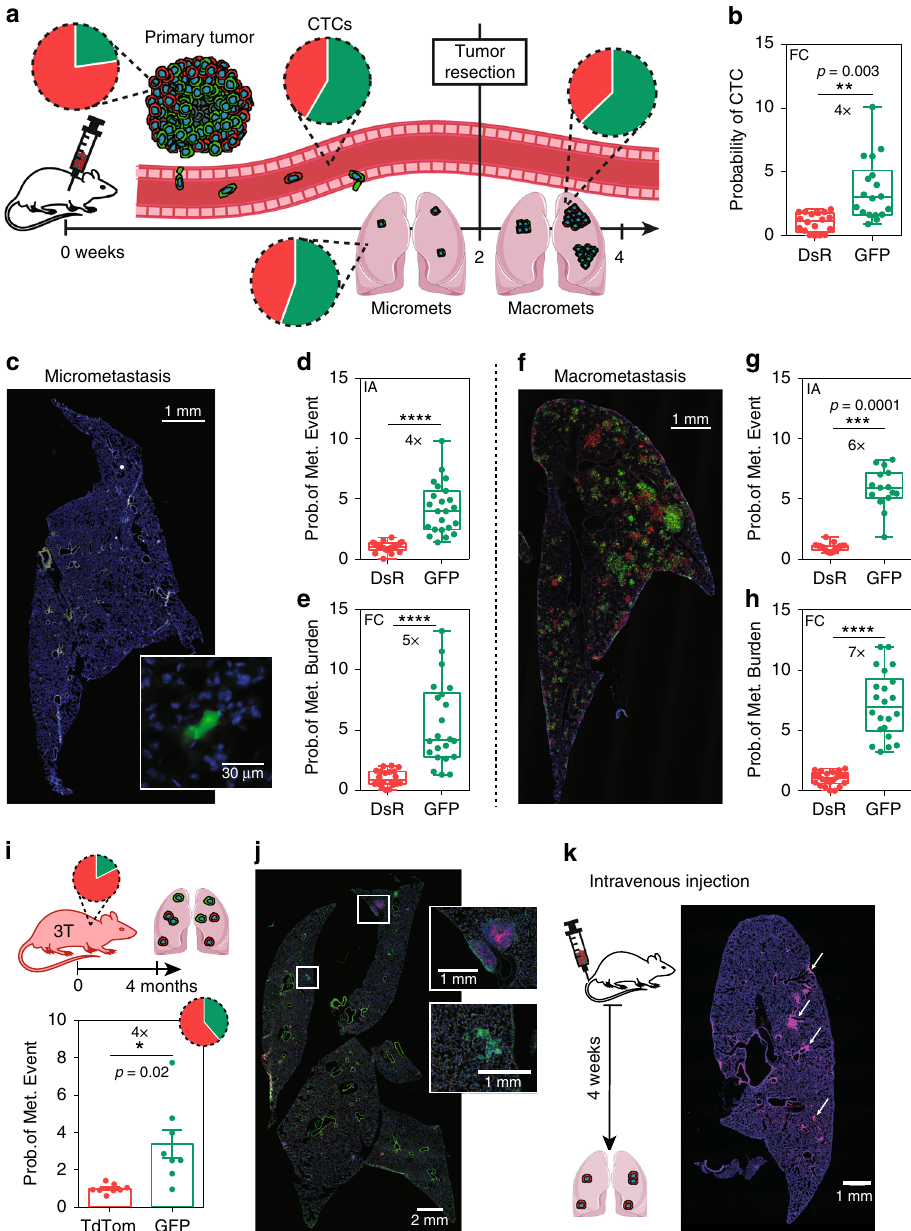
Fig. 6 Post-hypoxic cells have enhanced metastatic potential. a Orthotopic tumors derived from MDA-MB-231 hypoxia fate-mapping cells. Blood, lungs, and tumor were harvested at 2 weeks for half of the mouse cohort. Surgical tumor resection was performed on the second half of the cohort, and lungs were harvested 2 weeks after tumor removal to assess late-stage metastasis. Pie charts represent the ratio of DsRed + to GFP + cells in each site. b The probability of a GFP + (or DsRed + ) CTC in the blood was obtained by dividing the percentage of GFP + (or DsRed + ) CTCs detected in the bloodstream with the percentage of GFP + (or DsRed + ) cells in the matched primary tumor ( N = 3, n = 17) by using fl ow cytometry (FC); **** P < 0.0001 GFP versus DsRed (two-tailed t -test). c Cross-sectional imaging of DsRed and GFP expression and DAPI labeling of lung micrometastasis at week 2. The inset shows magni fi ed GFP + micrometastasis. d , e The probability of a GFP + metastatic event in the lung is obtained by dividing the percentage of GFP + micrometastases by the percentage of GFP + cells in the matched primary tumor by using d image analysis or e fl ow cytometry ( N = 3, IA: n = 23; FC: n = 22); **** P < 0.0001 GFP versus DsRed (two-tailed t -test). The box extends from the 25th to 75th percentiles, median is marked by the line inside the box, and whiskers represent the minimum and maximum. f Cross-sectional imaging of DsRed and GFP expression and DAPI labeling of lung macrometastasis 2 weeks after tumor resection. g , h The probability of a GFP + metastatic event in the lung is obtained by dividing the percentage of individual GFP + macrometastatic colonies by the percentage of GFP + cells in the matched primary tumor by using g image analysis or h fl ow cytometry ( N = 3, IA: n = 16; FC: n = 22); **** P < 0.0001 GFP versus DsRed (two-tailed t -test). i , j Tumor and lungs from triple-transgenic mice were harvested at 4 months of age. Probability of lung metastatic events was obtained as described in g (mean ± SEM, N = 8); **** P < 0.0001 GFP versus tdTom (two-tailed t -test). k MDA- MB-231 hypoxia fate-mapping cells were injected into the tail vein of NSG mice and harvested 5 weeks